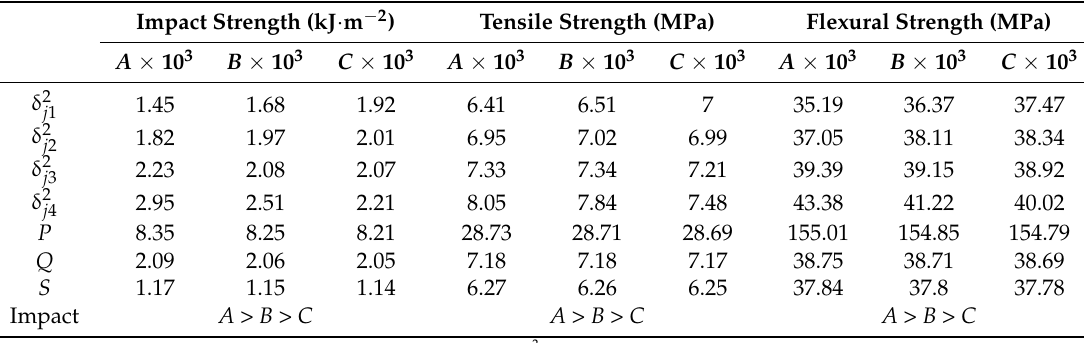
Table 4. Variance analysis of the impact, tensile, and flexural strengths of the wood fiber/ HDPE composites.